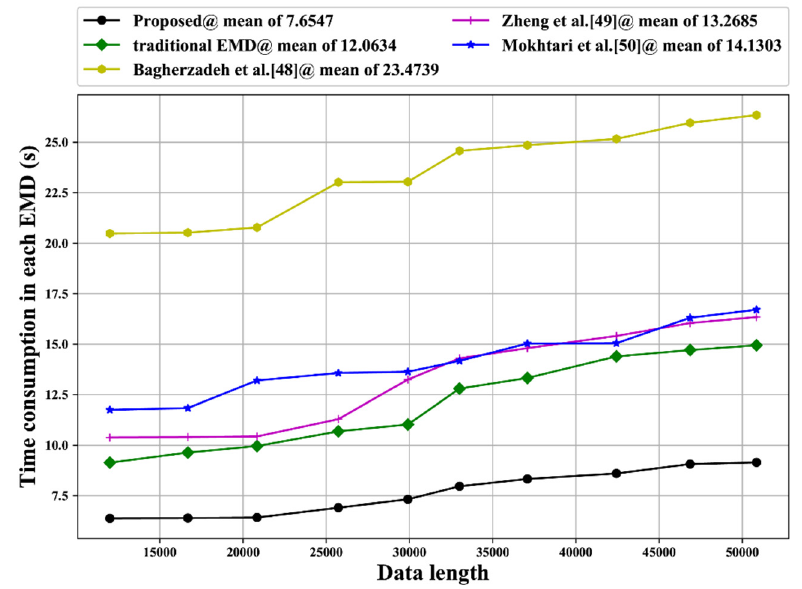
Figure 13. Time consumption comparison.